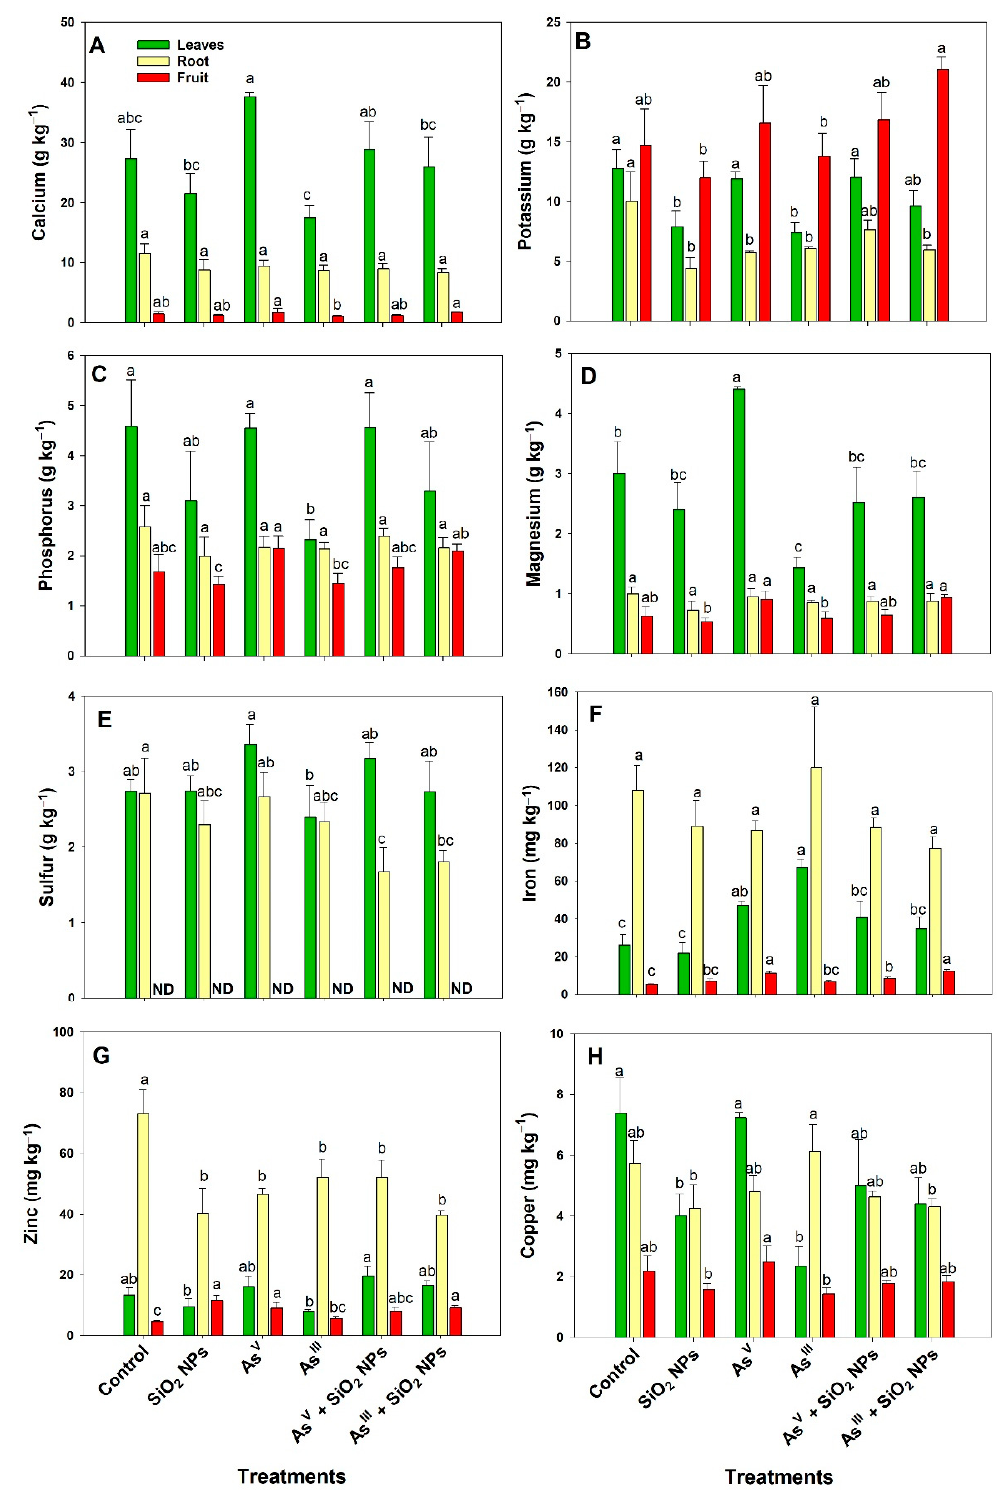
Figure 3. Macronutrients ( A – E ) and micronutrients ( F – H ) in leaves, roots, and fruits of tomato plants exposed to As V and As III in irrigation water and SiO 2 NPs via substrate. Plants treated with 3.2 mg L − 1 of As V (Na 2 HAsO 4 · 7H 2 O) and As III (NaAsO 2 ) via irrigation through the nutrient solution and 1000 mg L − 1 of SiO 2 NPs via substrate. ND: no detected. Lower-case letters different per bar indicate statistical differences according to the Fisher’s least significant difference test ( p ≤ 0.05). n = 5 ± standard error.